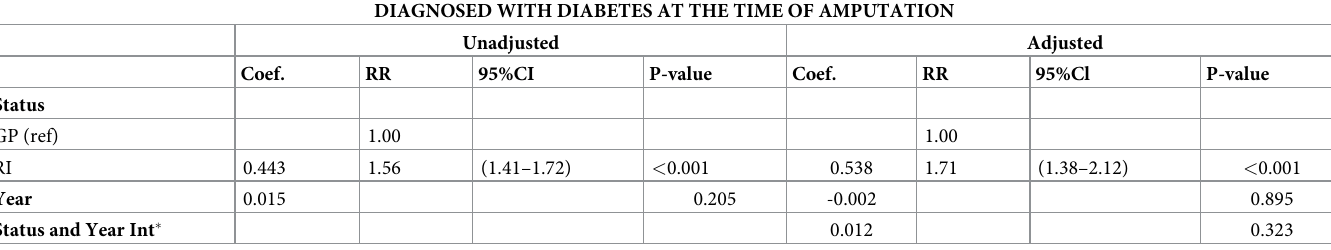
Table 4. Unadjusted and adjusted relative rates comparing amputation incidences diagnosed with diabetes at the time of amputation among registered Indians and general populations. DIAGNOSED WITH DIABETES AT THE TIME OF